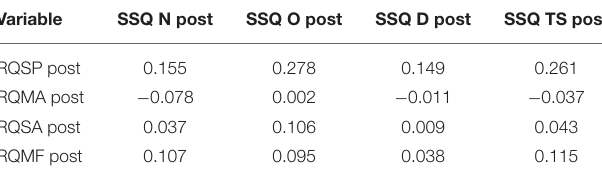
TABLE 4 | The Spearman’s correlation coefficients in relations between the post-exposure Romberg’s quotients and the post-exposure SSQ scores.